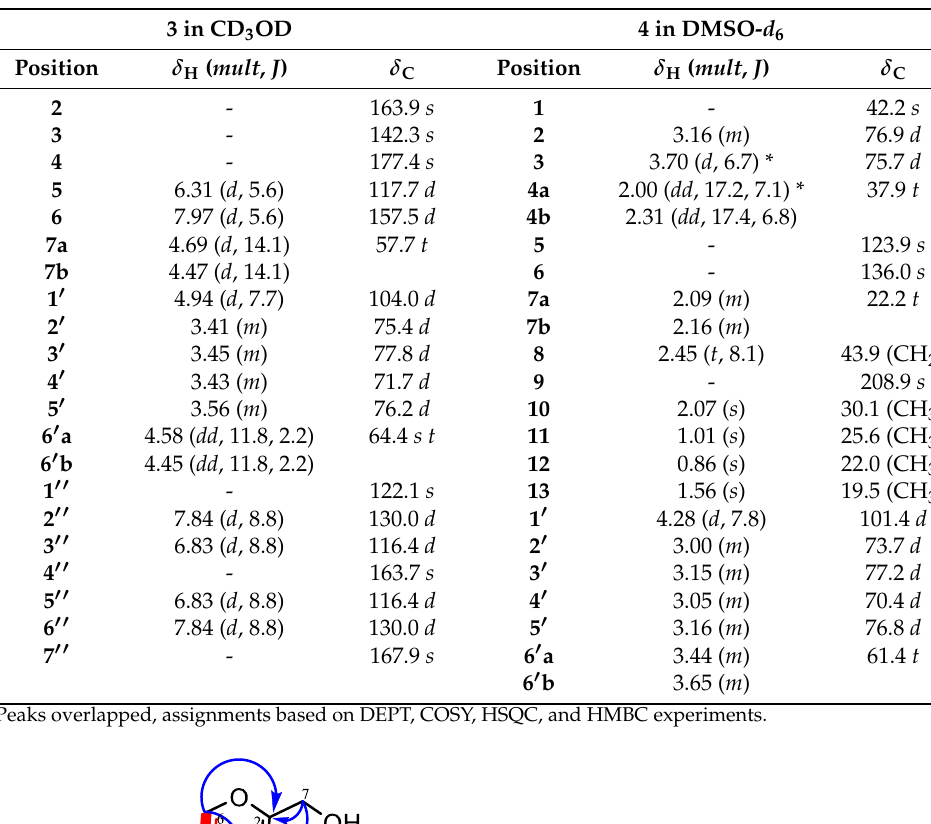
Table 2. 1 H and 13 C NMR data of compounds 3 and 4 .